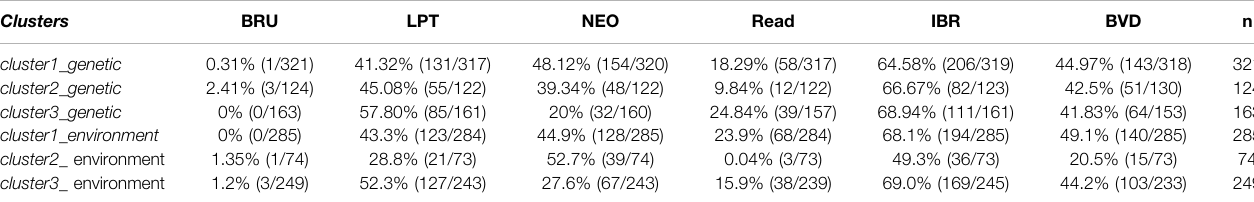
TABLE 7 | Frequency distribution of seropositive individuals against infections according to the classi fi cation by genetic and environmental clusters. Clusters BRU